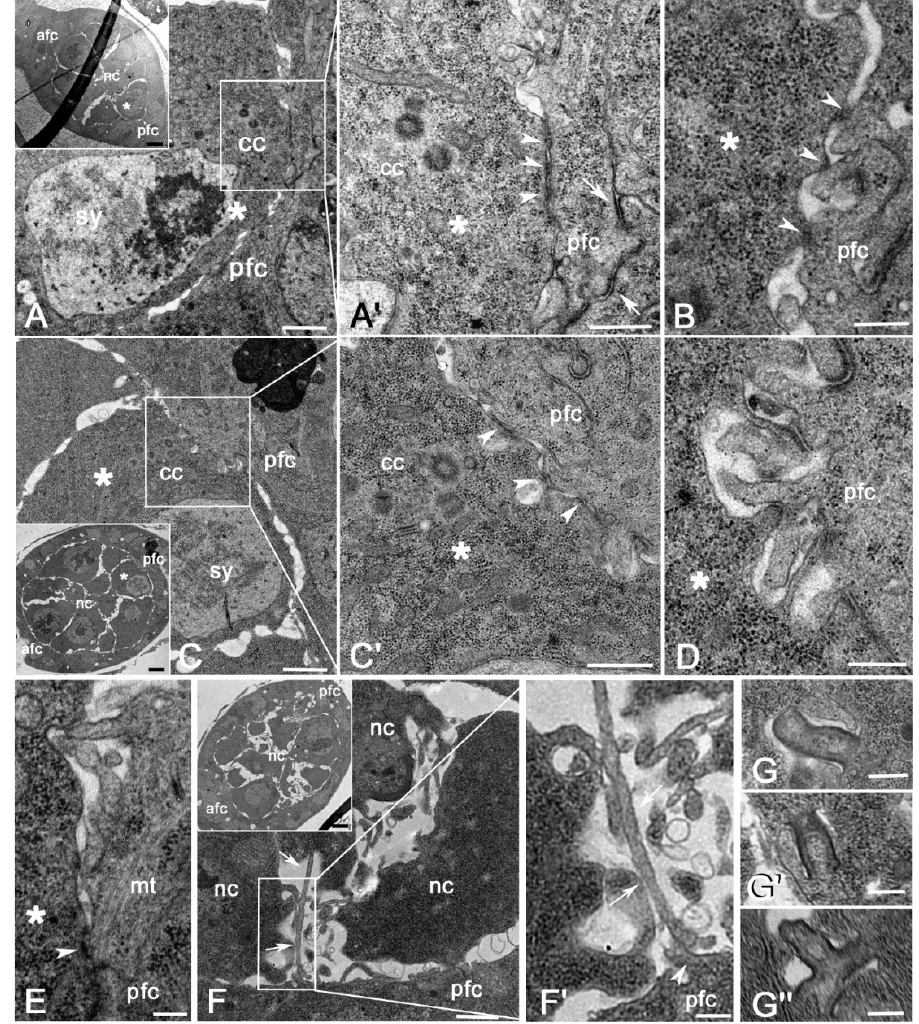
Figure 2. ( A ) The oocyte recognized by the synaptonemal complexes, and one cluster of centrioles contacts the follicle cells at the posterior end of the region 3 egg chamber. ( A’ ) Detail of the contact region between the oocyte and the follicle cells just over the centriole cluster: several short AJs (arrowheads) are observed at the interface between the opposing cells, whereas the convoluted apical region of the follicle cells displays large AJs (arrows). ( B ) Cross section at the interface between the oocyte and the follicle cells below the centriole cluster showing short protrusions of the oocyte membrane in contact with the apical surface of the follicle cells; the protrusions of the oocyte show a dense material restricted to the oocyte side of the plasma membrane (arrowheads). ( C ) Stage 2 egg chamber: the contacts between the oocyte and the posterior follicle cells are more evident in correspondence of the centriole cluster. ( C’ ) Detail of the interface between the oocyte and the follicle cells in correspondence with the centriole cluster: several short AJs are present (arrowheads). ( D ) Section below the region of the centriole cluster showing intermingled projections of the oocyte and the follicle cells. ( E ) Detail of the contact area between the oocyte and the follicle cells showing distinct microtubules ending toward the AJ (arrowhead). ( F ) Cross section and ( F’ ) detail of the posterior region of a stage 2 egg chamber: the peripheral germ cells show elongated projections (arrows) that come in contact among them or with short protrusions (arrowhead) of the follicle cells. ( G – G” ) Details of some midbody remnants found in the follicle cells. asterisk, pro-oocyte; sy, synaptonemal complexes; cc, cluster of centrioles; afc, pfc, anterior and posterior follicle cells; mt, microtubules nc, nurse cells. Scale bars: ( A , C , F ), 1 µ m; ( B , D ), 0.2 µ m; ( A’ , C’ ), 0.3 µ m; ( E , F’ ), 0.2 µ m; ( G – G” ), 0.2 µ m; insets ( A , C , F ), 3 µ